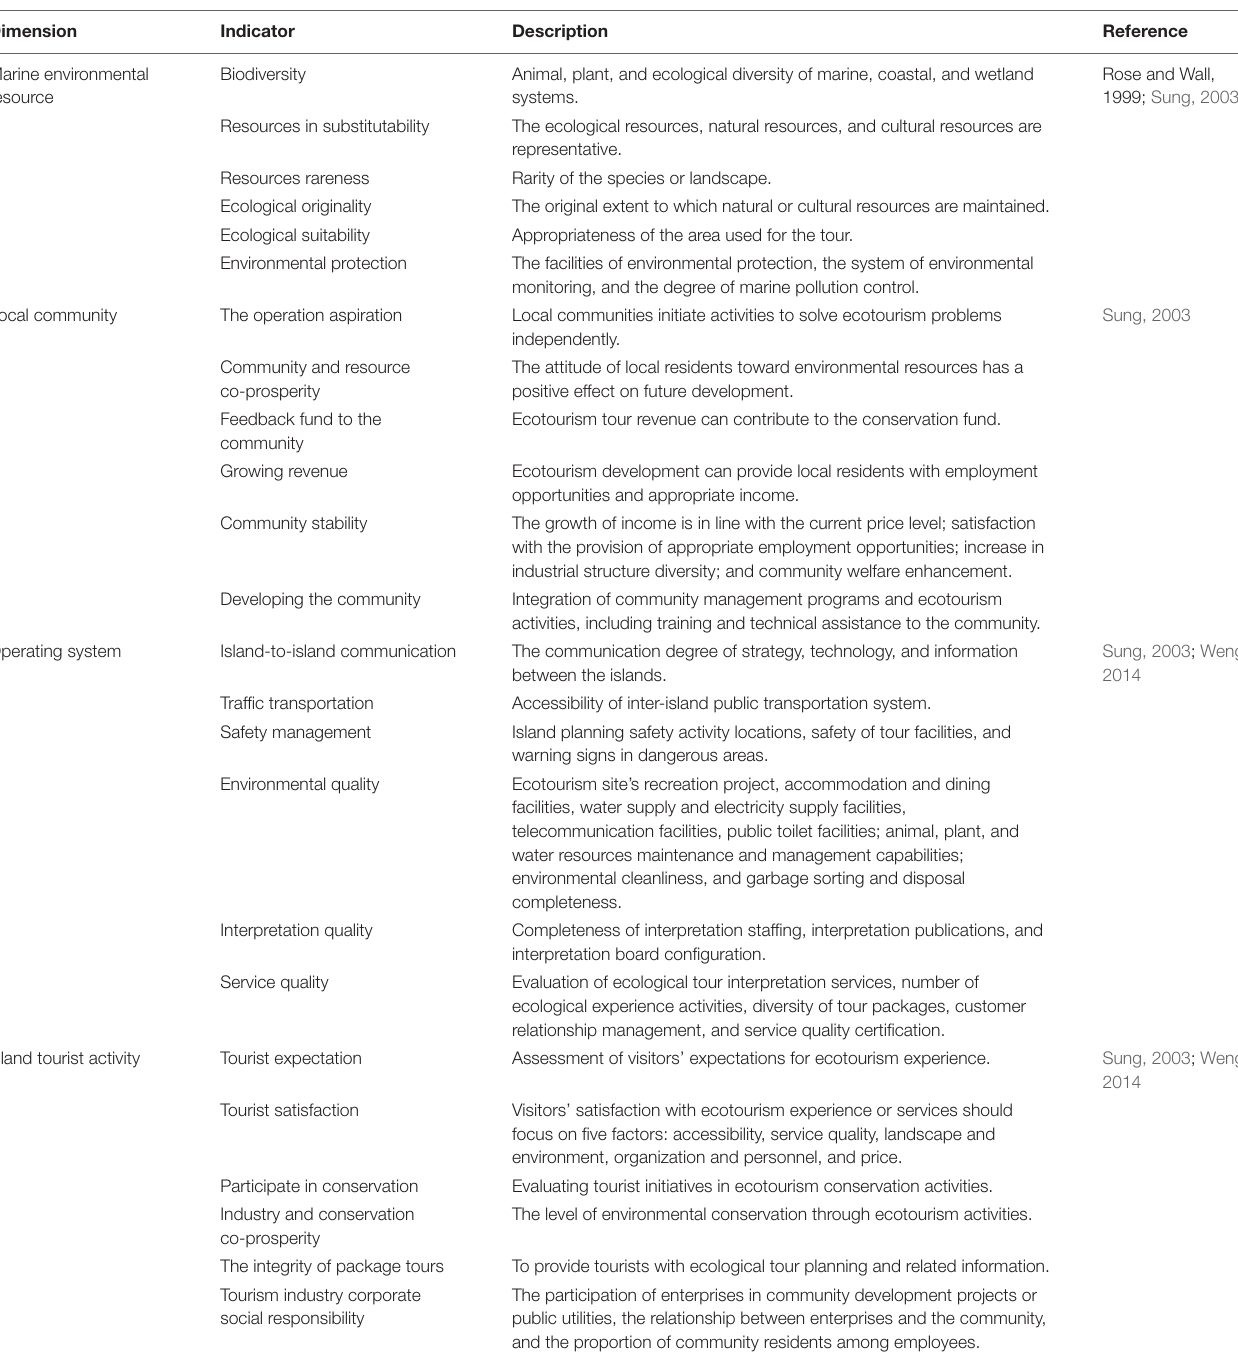
TABLE 1 | The dimension and factors employed in assessing the ecological tourists service